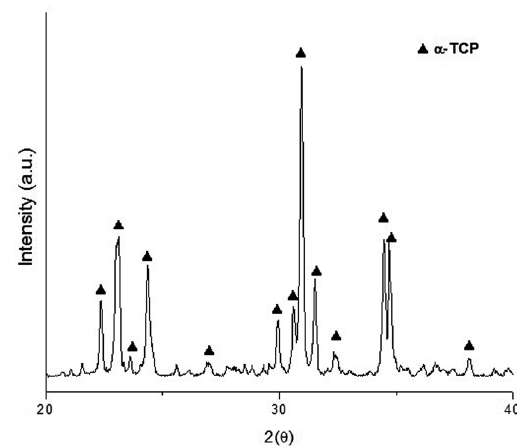
Figure 2: XRD pattern for the powder synthesized through wet precipitation method and charred at 1400°C for an hour.